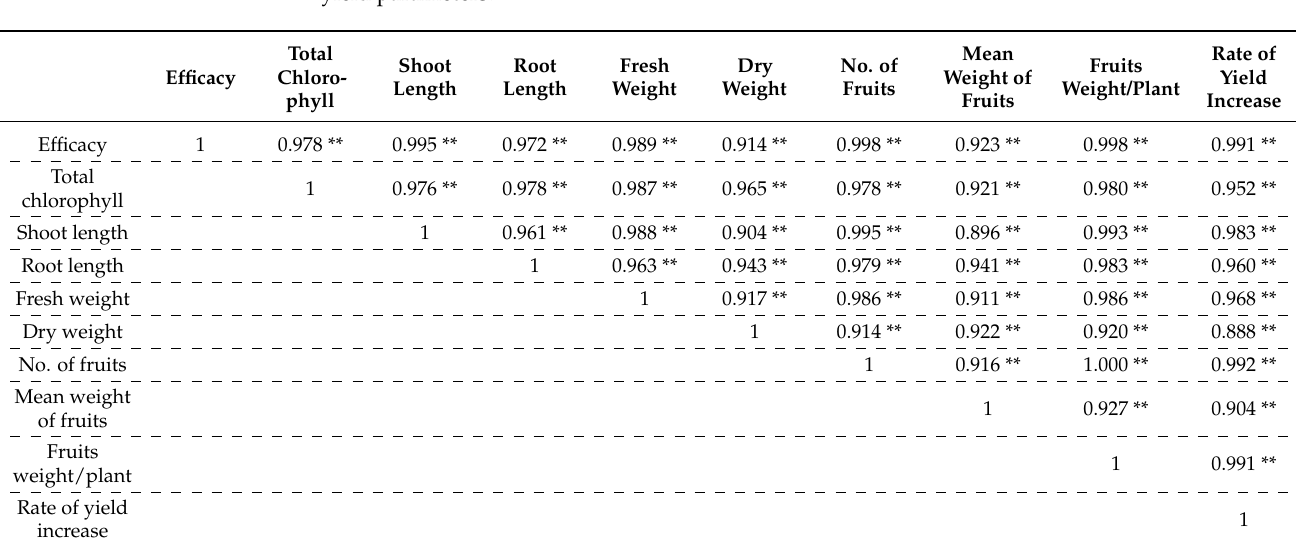
Table 8. Pearson correlations between efficacy and total chlorophyll and growth parameters and yield